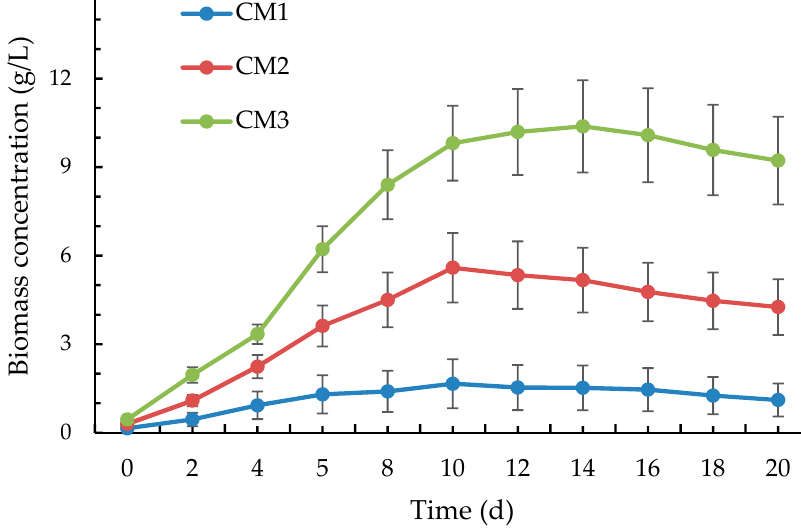
Figure 1. Production of biomass in culture media with different concentrations of vinasse.